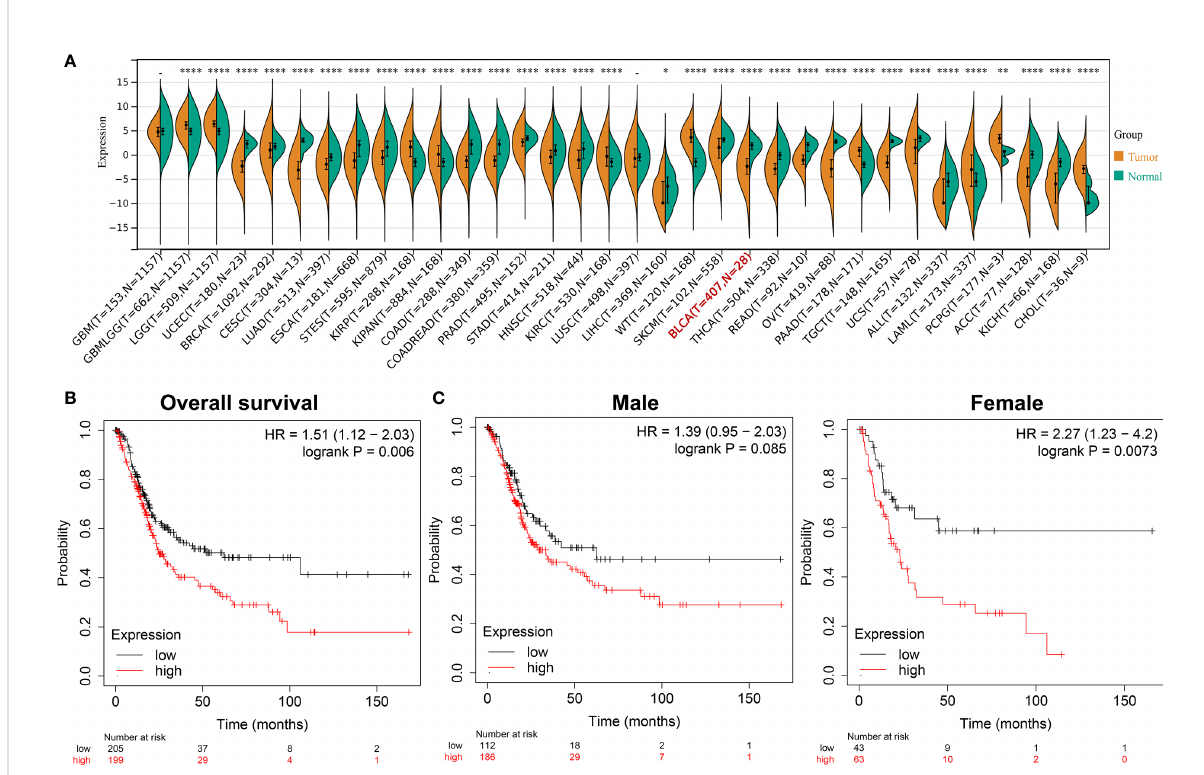
FIGURE 4 Survival outcomes of ADCY2 expression in cancers and novel role in BCa. (A) Differential expression of ADCY2 in tumor and normal tissues in pan-cancer. (B) Overall survival curve of BCa patients. (C) Survival curves of male and female in high and low expression groups. *p<0.05; **p<0.01;